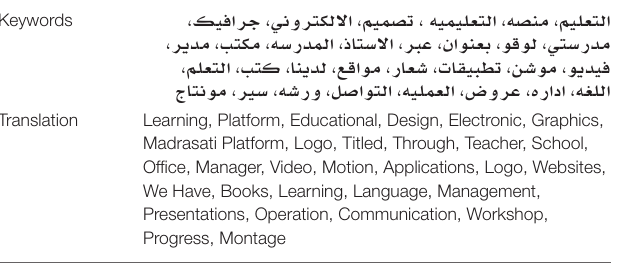
Table 5 | The keywords and their English translation for Figure 5 .